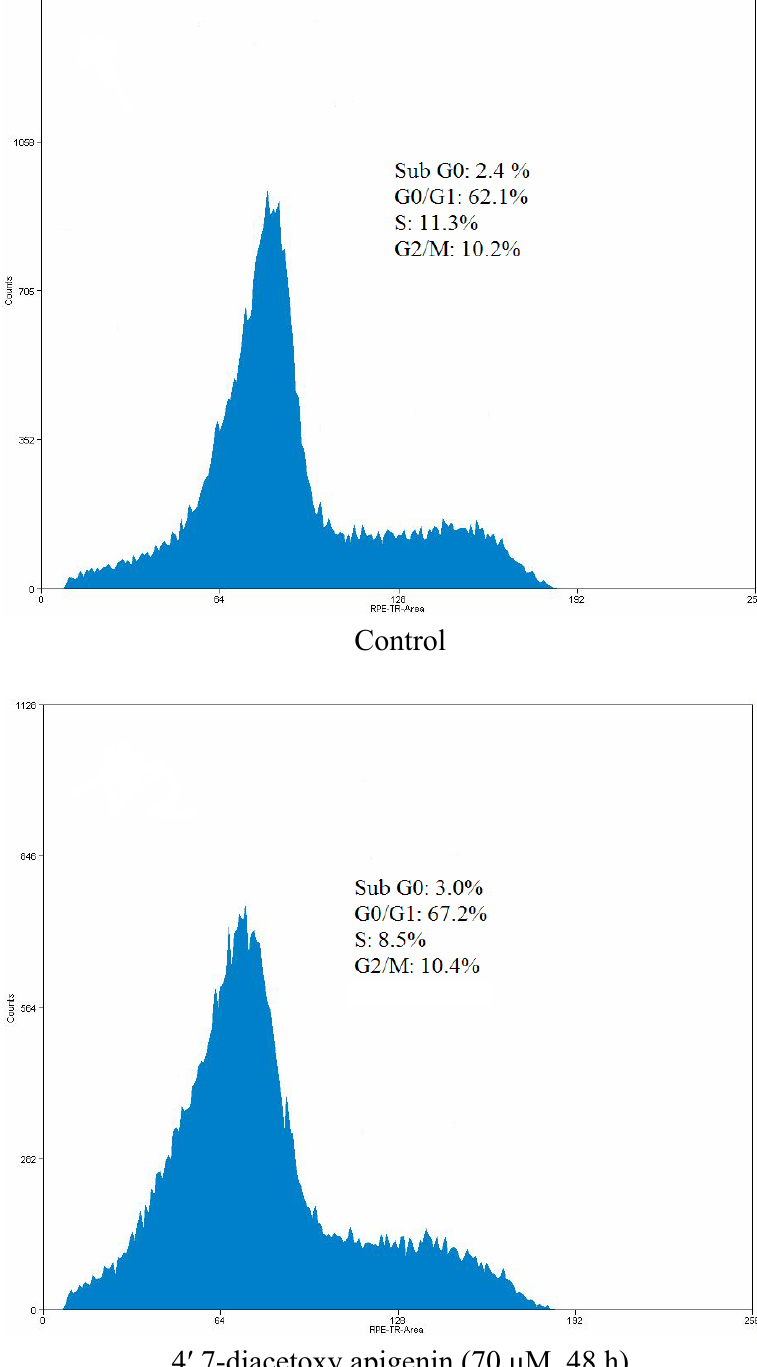
Figure 4. Effect of 4 ′ ,7-diacetoxyapigenin on cell cycle distribution in Hep G2 cells.